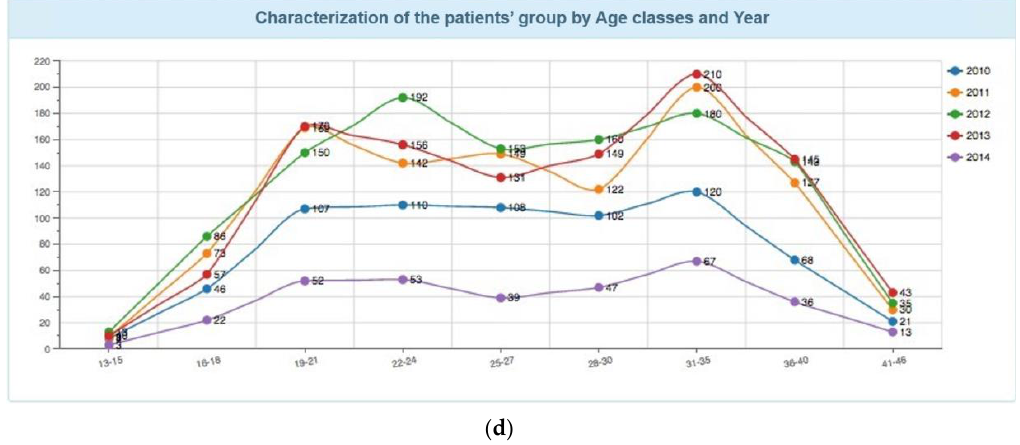
Figure 1. CMIN’s BI application using Pentaho BI Suite software: ( a ) presents the obstetrical history of the patients; ( b ) shows the association between the women and contraception usage ; ( c ) presents the distribution of the gestational age of the patients at the begin of the abortion process; ( d ) makes an overview of the patients by age classes and years.